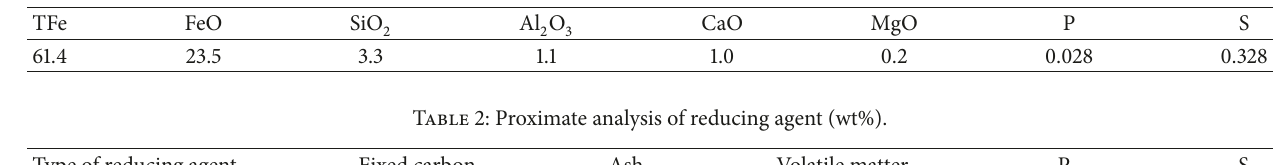
Table 1: Chemical composition of iron ore (wt%).